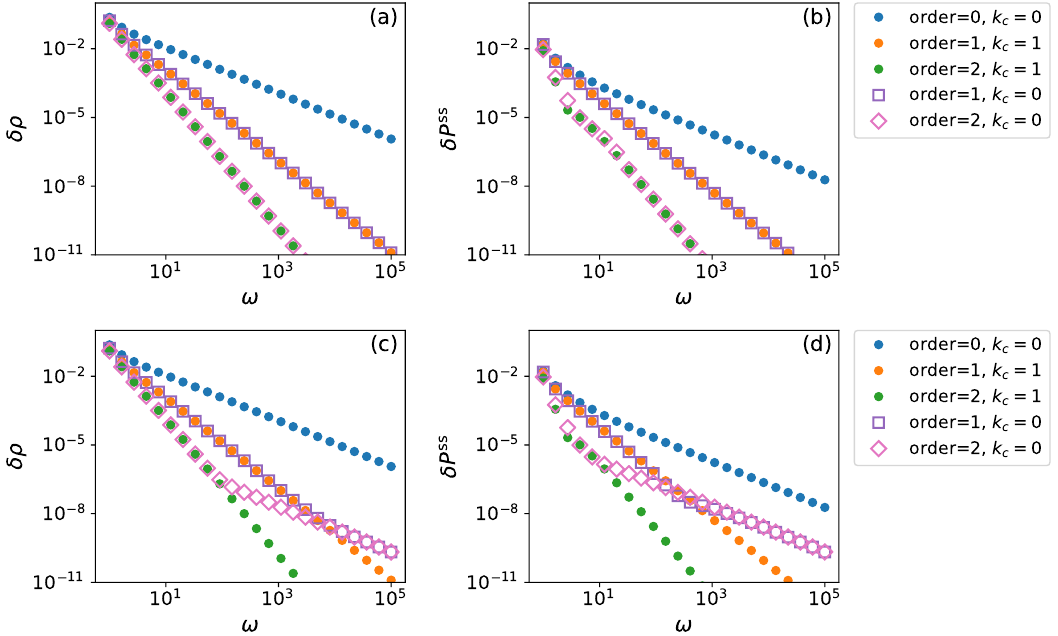
Figure 9: Accuracy of HF expansion approach for the NESS density matrix δρ (left panels) and the Floquet-state population δ P ss (105) (right panels) plotted N against ω for the bath spectral cutoffs Λ = 10 (upper panels) and 10 6 (lower panels). ) as shown in legend, for which we use Each data set corresponds to a pair of ( N , k c H and K ( t ) expanded up to O ( ω − N ) . The other parameters are chosen as B eff = 1, N = 0.05, B = 0.1, γ = 0.2, and β = N z x y d 0